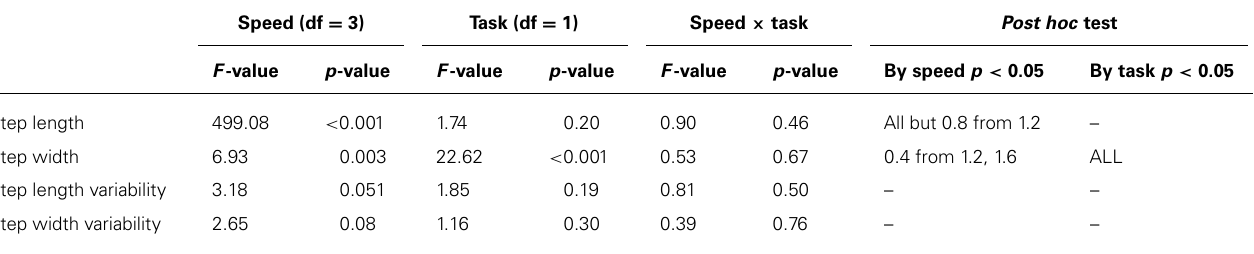
Table 2 |ANOVA table showing F and p -values for speed, task, and speed × task interaction. Speed (df = 3) Task (df = 1) Speed × task Post hoc